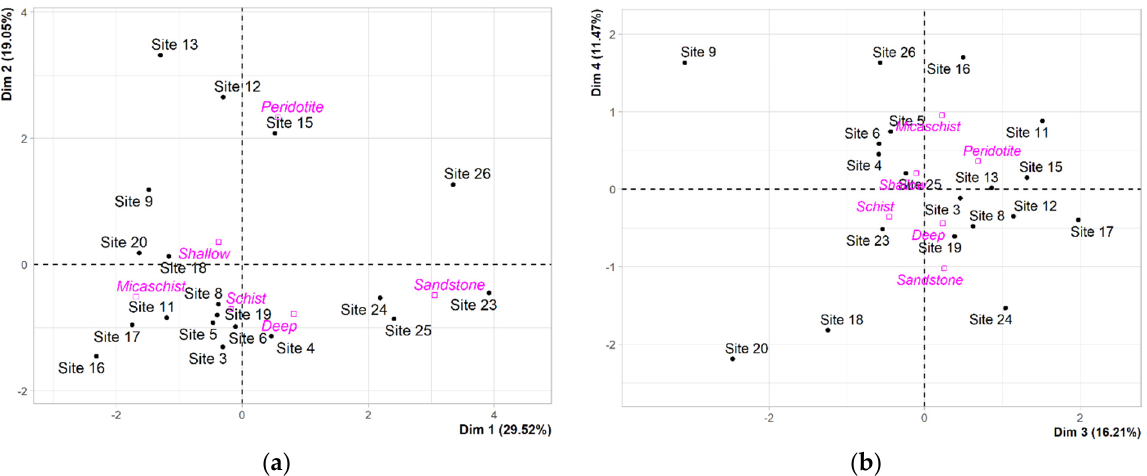
Figure 10. Graph of individuals. ( a ) According to axes 1 and 2; ( b ) according to axes 3 and 4.